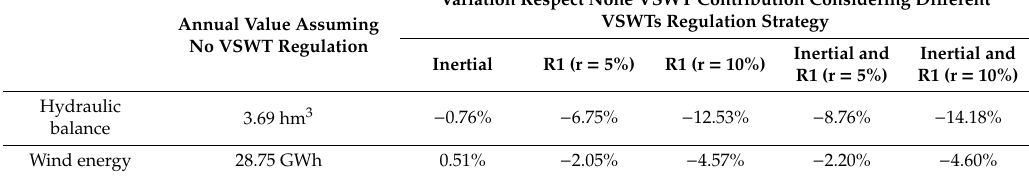
Table 6. Aggregated comparison of the hydraulic balance (di ff erence between pumped and turbined volume) and wind energy produced between none VSWT contribution and the proposed VSWT regulation